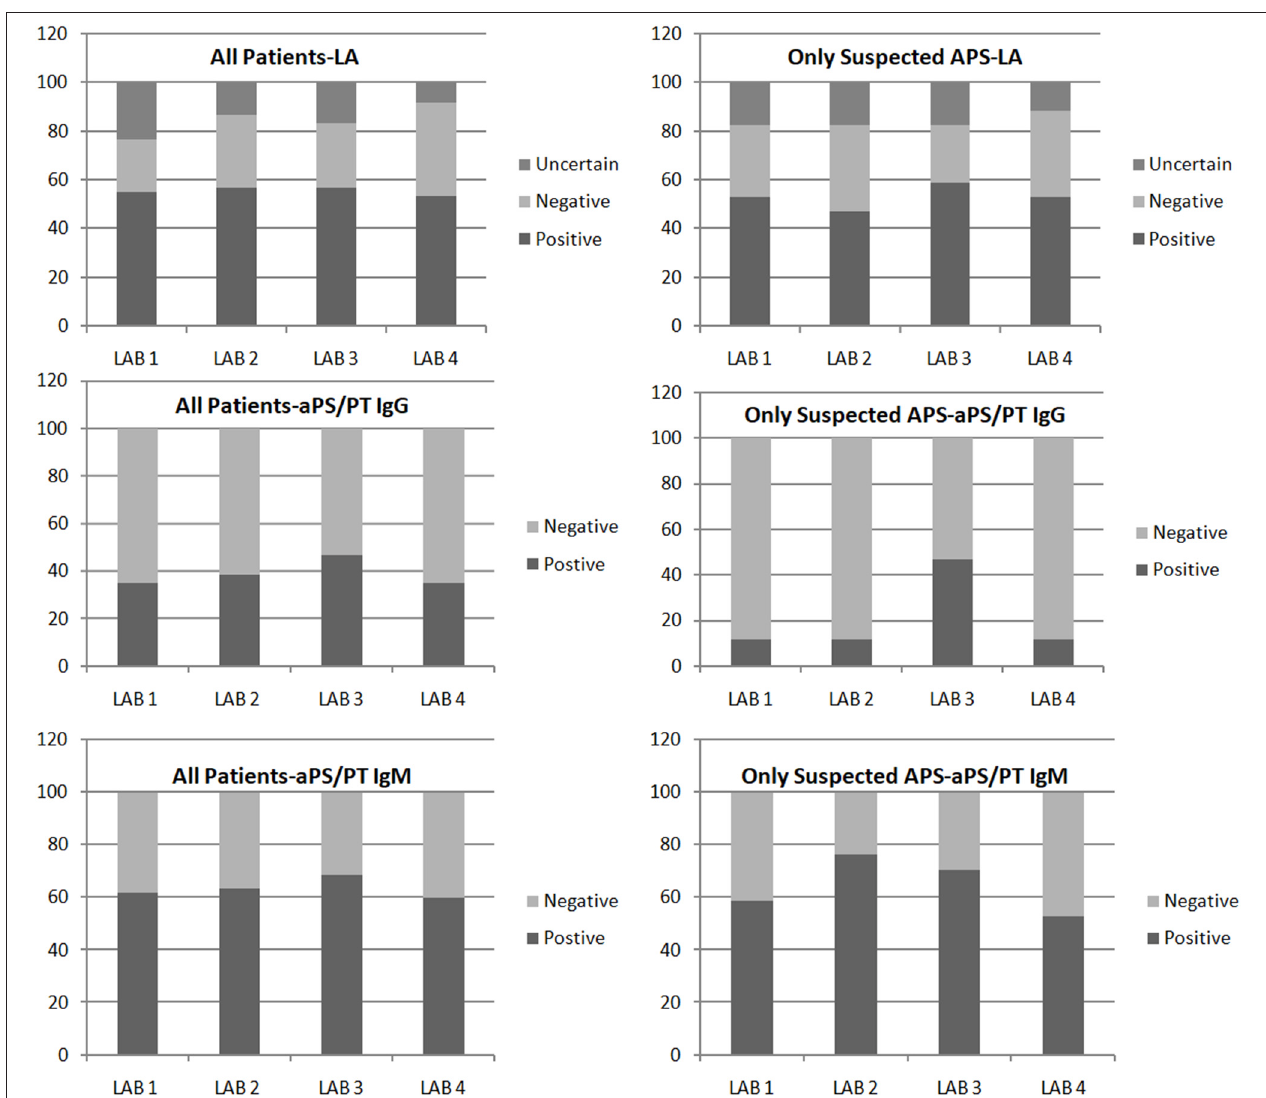
FIGURE 1 | Results of lupus anticoagulant (LA) and anti-PS/PT antibody obtained in four laboratories. Results are summarized for all the patients included in the study (Left) and for patients with suspected APS (Right)